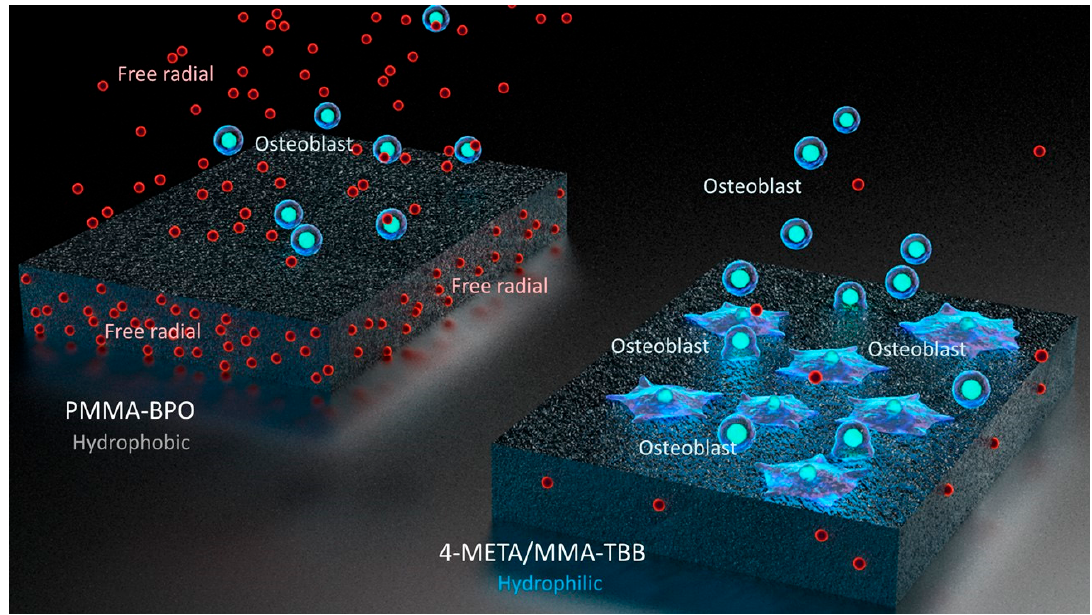
Figure 14. Schematic diagram of unique physicochemical property of 4-META/MMA-TBB characterized by a hydrophilic surface and minimal free radical production during polymerization, osteoblastic attachment and subsequent osteogenic